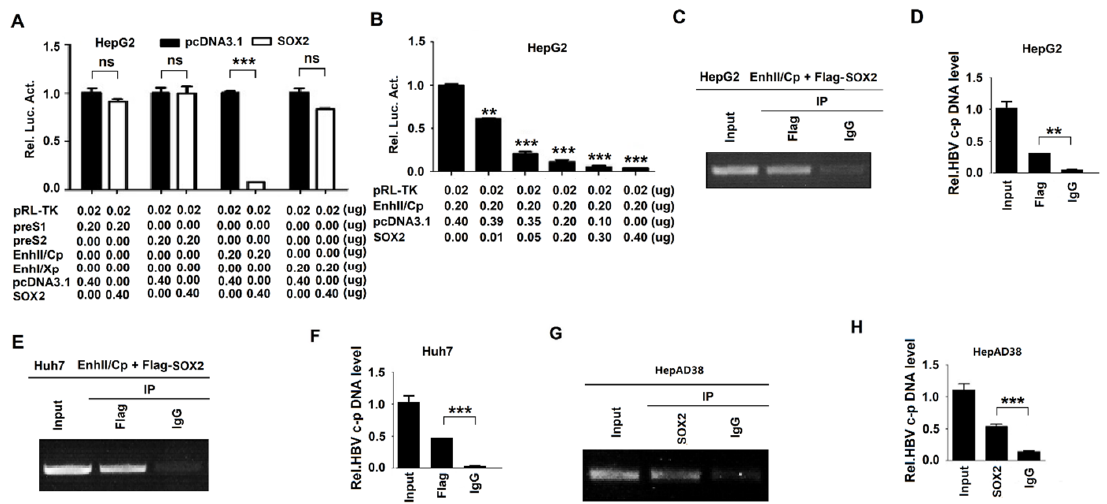
Figure 3. SOX2 represses HBV replication through inhibiting the activation of EnhII/Cp. ( A )